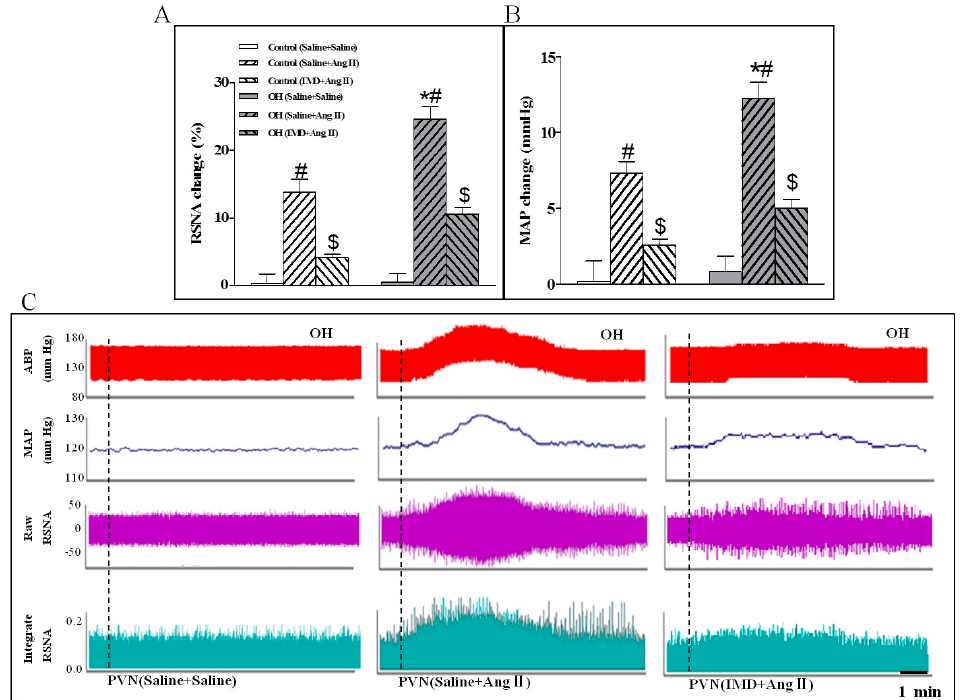
Figure 3. Statistical analysis ( A , B ) and representative recordings in OH rats ( C ) showing the effects of saline or IMD (50 pmol) pretreatment in the PVN on RSNA and MAP responses to Ang II (0.3 nM) in control and OH rats. Ang II was administered 45 min after the pretreatment. Values are mean ± SEM. * p < 0.05 versus control. # p < 0.05 versus saline + saline. $ p < 0.05 versus saline + Ang II. n = 6 for each